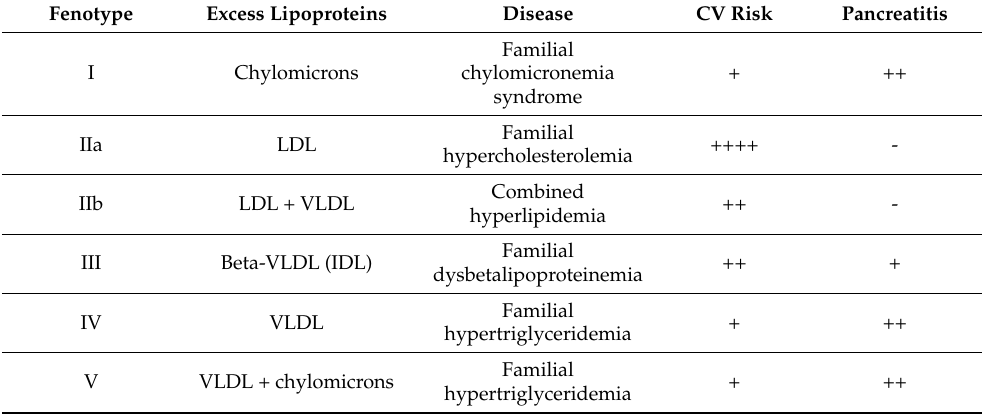
Table 1. Fredrickson’s Classification of Hyperlipidemia and association with risk of cardiovascular disease and pancreatitis. Fenotype Excess Lipoproteins Disease CV Risk Pancreatitis Familial chylomicronemia + ++ I Chylomicrons syndrome Familial ++++ - IIa LDL hypercholesterolemia Combined hyperlipidemia Familial Beta-VLDL (IDL)